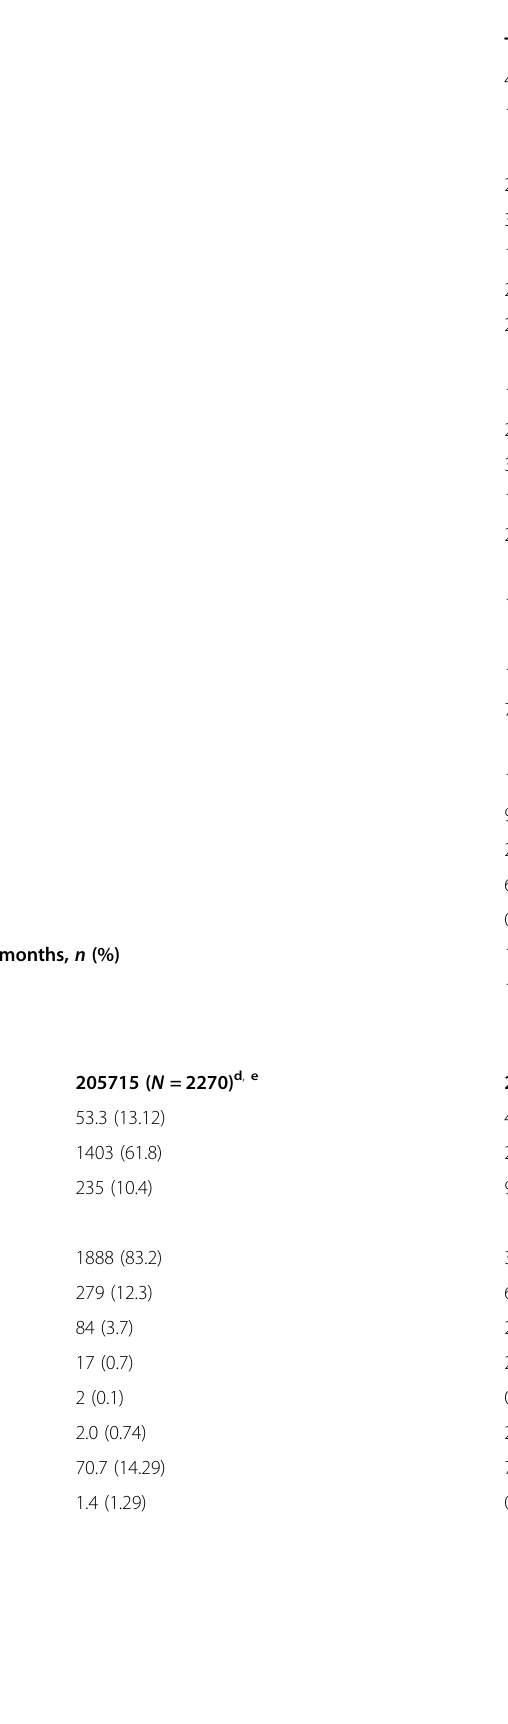
Table 1 Demographics and clinical characteristics in Phase 1 and Phase